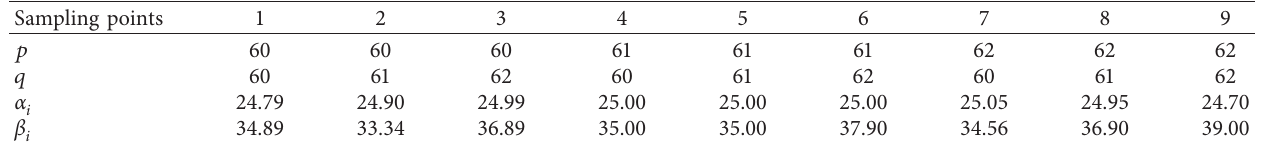
Table 2: Polarization state in the